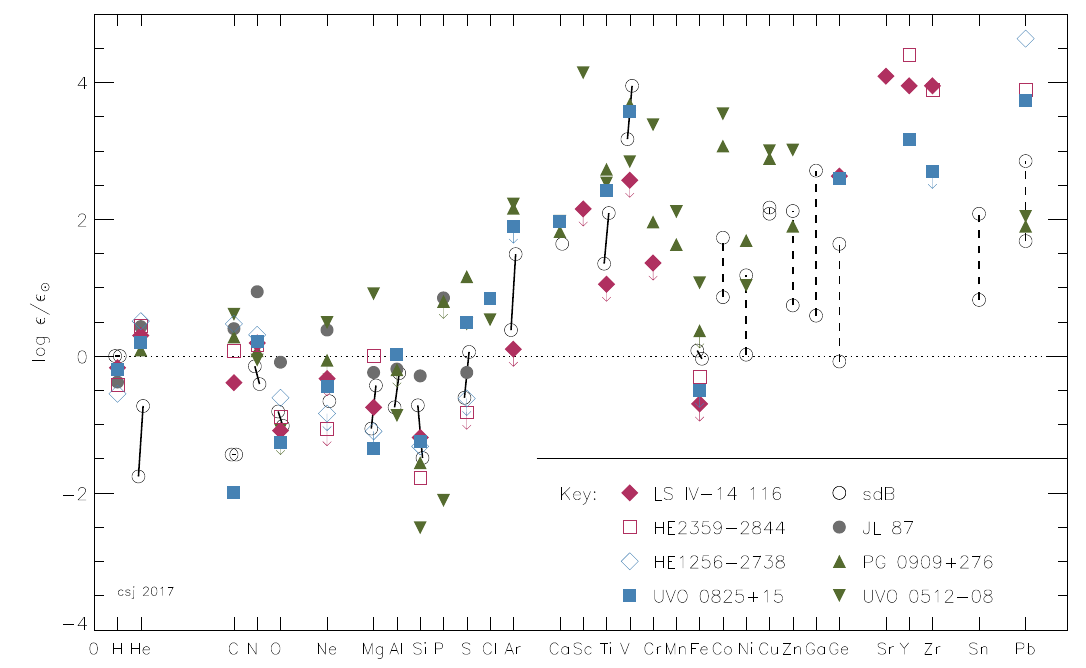
Figure 3. Surface abundances of super metal-rich hot subdwarfs, including the pulsating stars LS IV−14 ∘ 116 and UVO 0825+15, and the two stars considered in this paper; PG0909+276 and UVO0512–08. Abundances are shown relative to solar values (dotted line). Mean abundances and ranges for the helium-rich subdwarf JL 87 (Ahmad et al. 2007) and for normal subdwarfs are also shown. The latter are shown by connected open circles as (i) Z ≤ 26 (solid lines): the average abundances for cool and warm sdBs (Geier 2013) and (ii) Z ≥ 27 (broken lines): the range of abundances measured for five normal sdBs from UV spectroscopy (O’Toole & Heber 2006). Adapted from Jeffery et al.